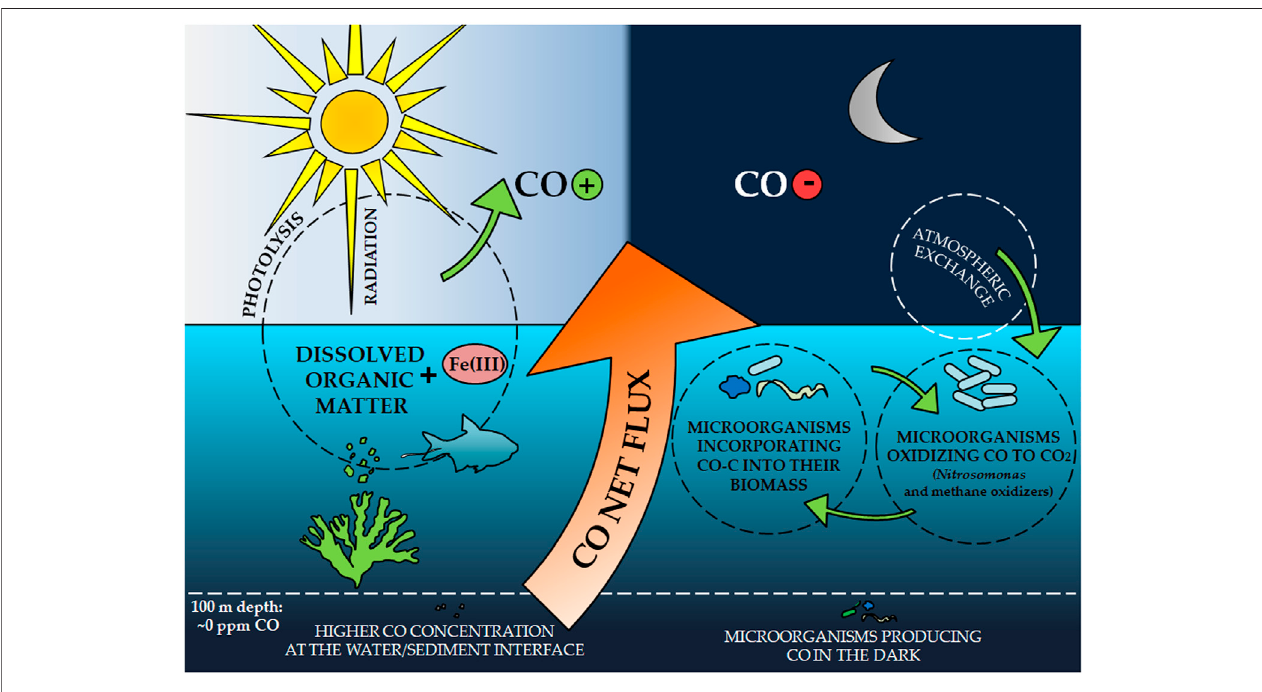
FIGURE 2 | Carbon monoxide cycle in